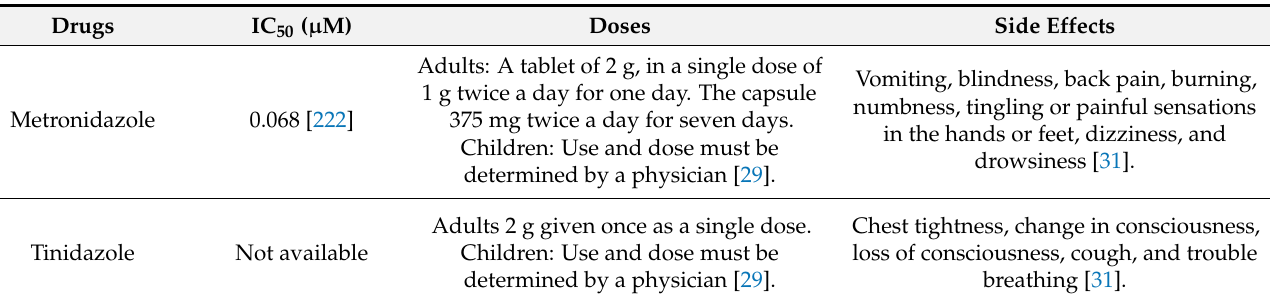
Table 7. Drugs used for pharmacological treatment of